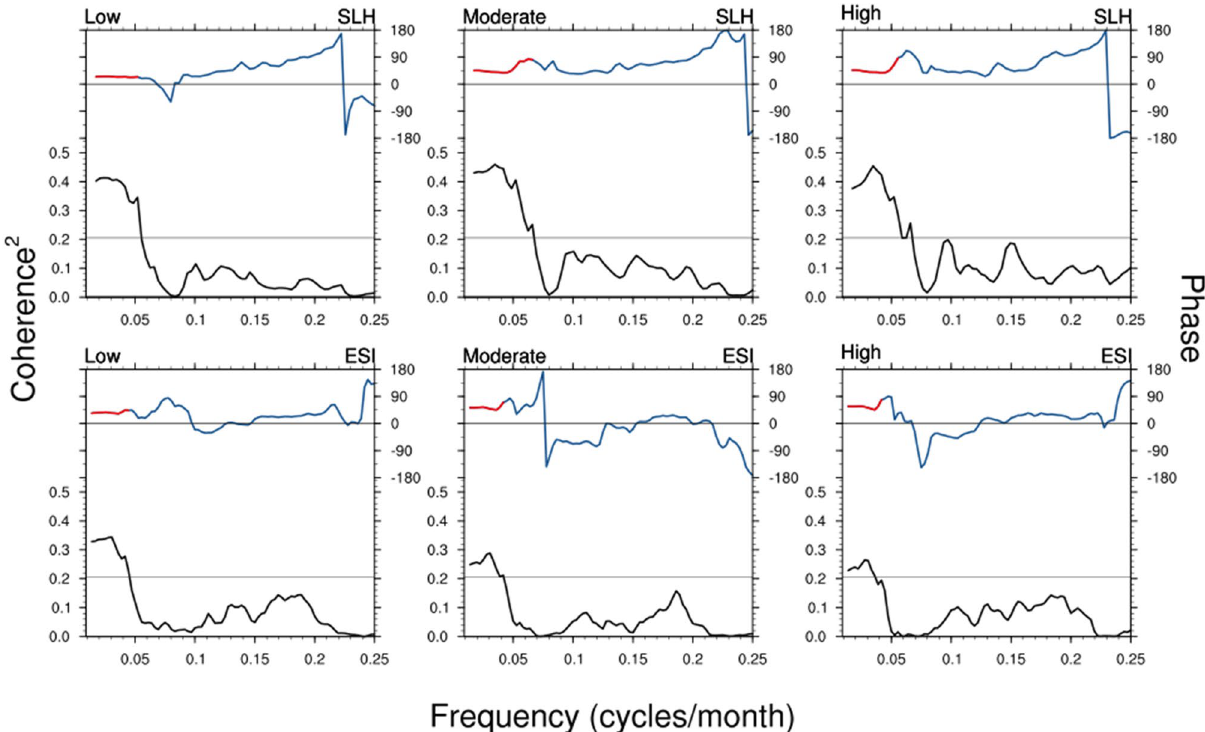
Figure 3. The coherence-squared spectrum (black curve, below) and phase (blue curve, top) between sea level height (SLH) at Milner Bay and mangrove FCC for the three dieback categories of low, moderate, and high (top panels). The same with coastal Gulf area-averaged ESI is shown at the bottom panels. The gray line shows a 5% level of significance for coherence-squared values. Phase lags are shown in red where the coherence squared is significant at 5% level. Plots are generated using the NCAR Command Language version 6.6.2 (http:// www. ncl. ucar.